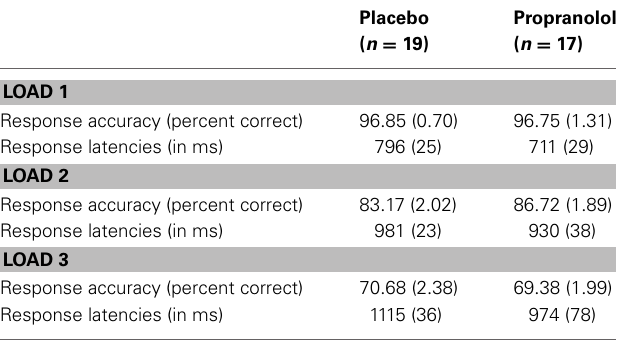
Table 2 | Behavioral results from the working memory task.